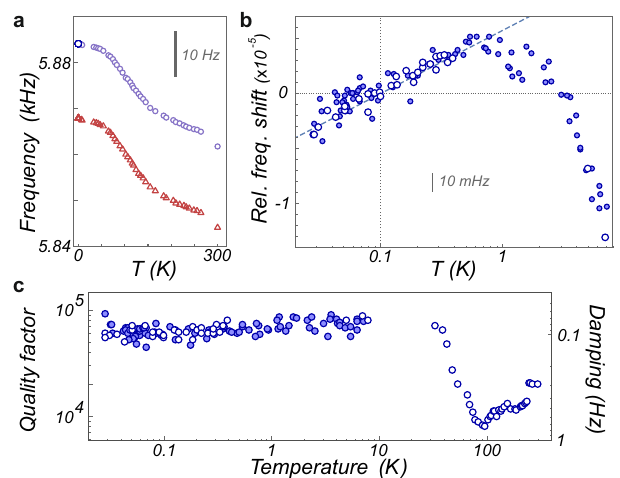
Fig. 4 Mechanical properties. a Temperature dependence of the eigenfrequencies of the 5.8 kHz nanowire (B). b , c Evolution of the relative frequency shifts and mechanical damping rates (mode 2) below 10 K. The open circles are obtained at minimal optical powers (sub pW), while varying the cryostat temperature. The full disks represent the frequency shifts and damping rates measured for increasing optical powers (from 100 fW to 10 nW, cryostat set at 20 mK), as a function of the measured effective noise temperature (after subtraction of a 30 mK of arti fi cial noise contribution). The dashed line in ( b ) corresponds to Δ